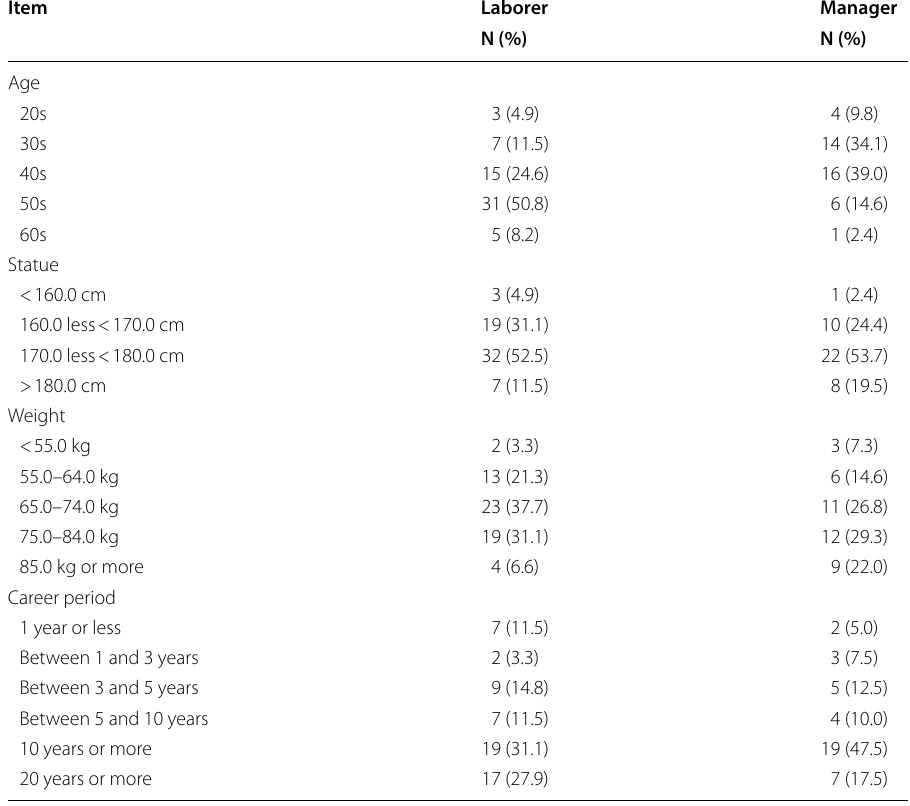
Table 3 Demographic characteristics by job